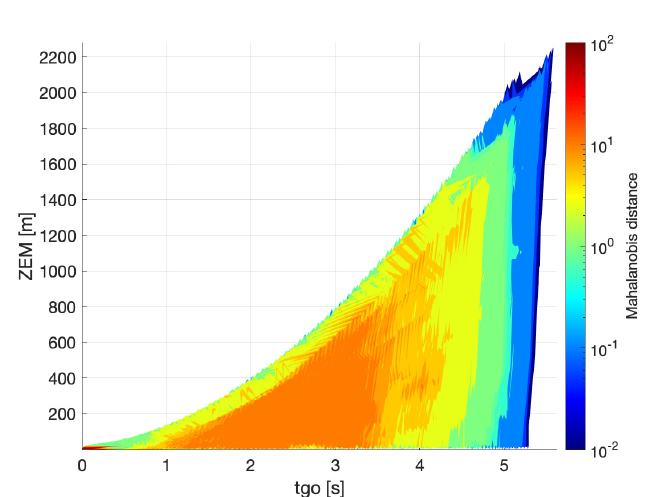
Figure 5. d M ( ZEM ) calculated with CRLB—Bearings + Range measurements.